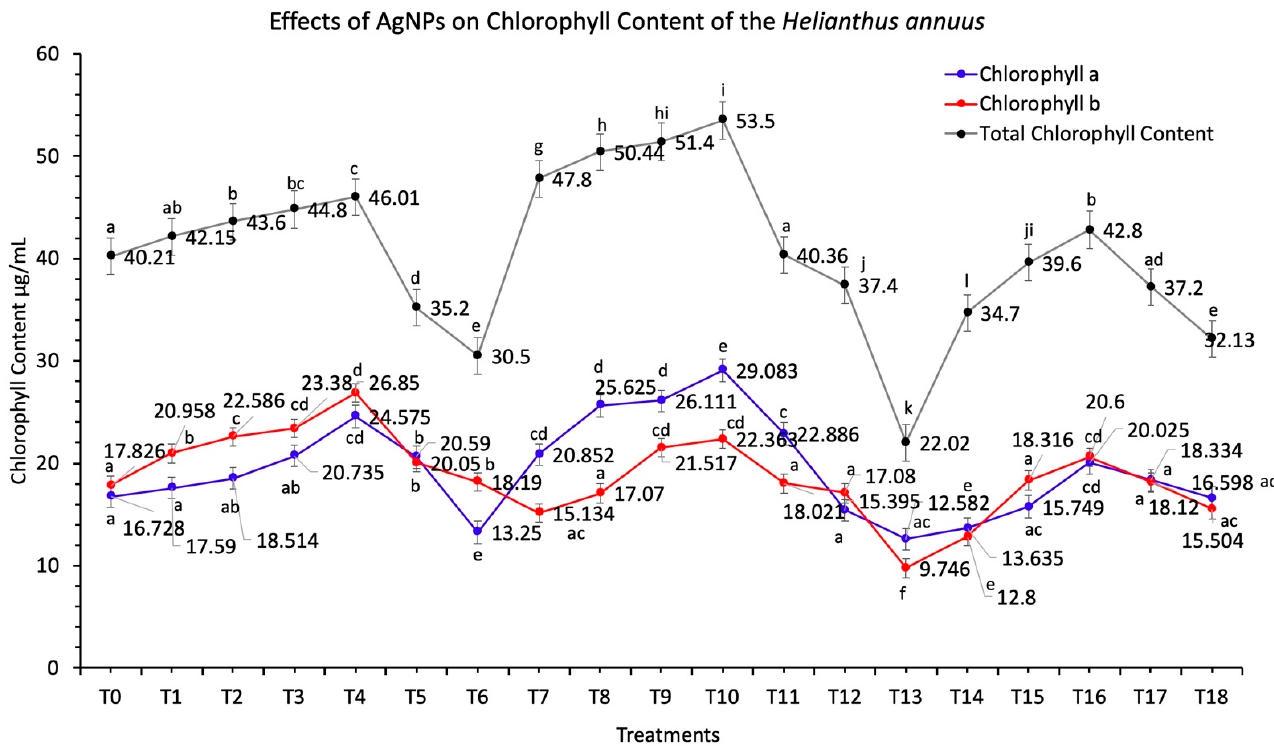
Figure 5. Effects of different treatments of AgNPs on chlorophyll contents of sunflower. Lowercase letters differed significantly at 5% probability levels, using Duncan’s Multiple Range Test ( p < 0.05).